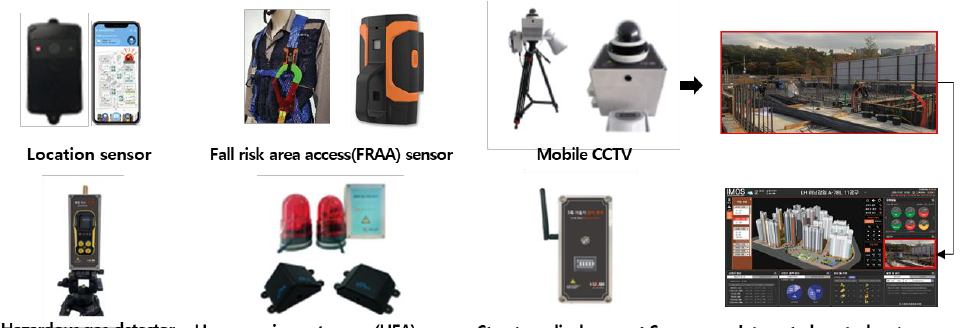
Figure 7. Types of SCSTs used in the test beds.